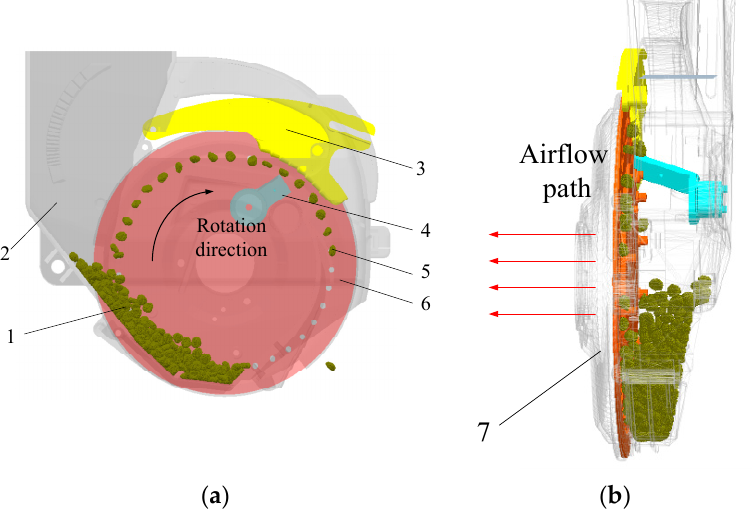
Figure 1. ( a ) Main view ( b ) Left view. Disturbance-assisted seed filling high-speed air-suction seed- metering device model: (1) seed group in seed filling area, (2) seed metering housing, (3) upper scraper, (4) lower scraper, (5) stably adsorbed seeds, (6) vacuum meter seed disk, (7) vacuum chamber.